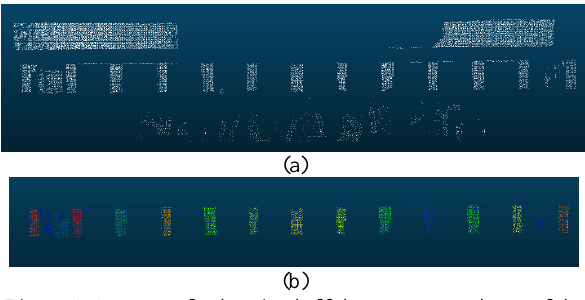
Figure 4. An example showing half the cameras and one of the projectors suspended from the support frame